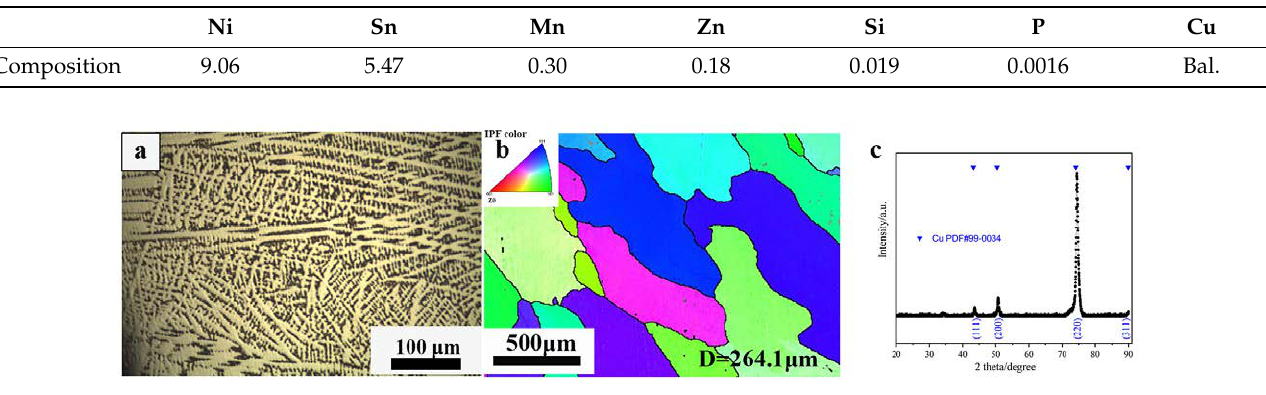
Figure 1. Microstructure of the Cu–9Ni–6Sn alloy before the test: ( a ) optical microstructure of the casted alloy; ( b ) IPF map of the homogenized alloy from an ND direction; ( c ) XRD results of the homogenized alloy.